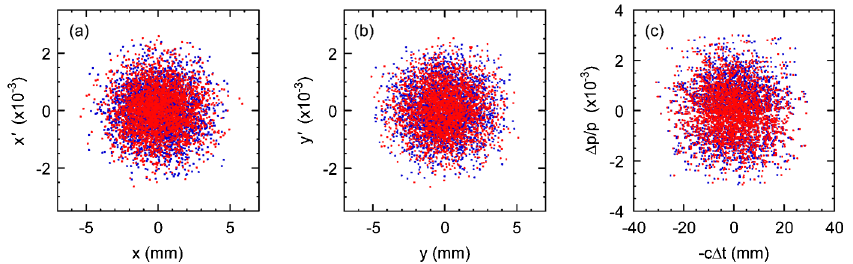
FIG. 8. Horizontal (a), vertical (b), and longitudinal (c) phase-space distributions of a 2 : 4 GeV =c muon bunch before (blue) and after (red) passing through the droplet